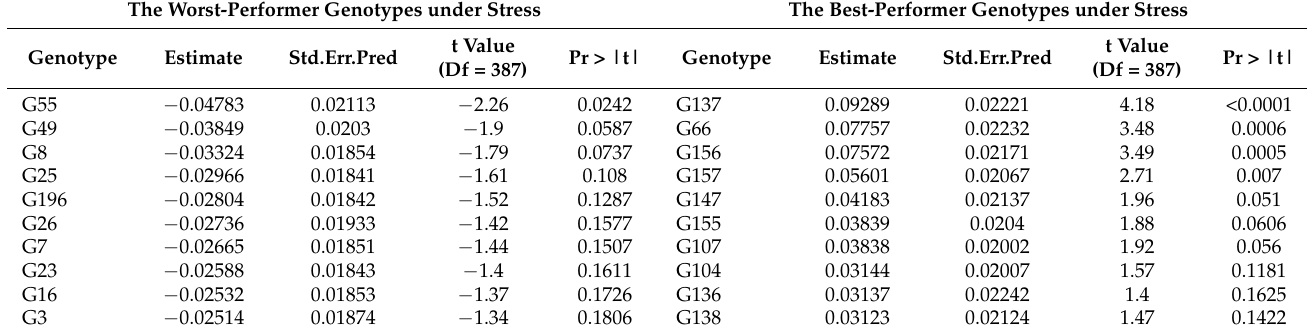
Table 8. The performance of Genotypes under